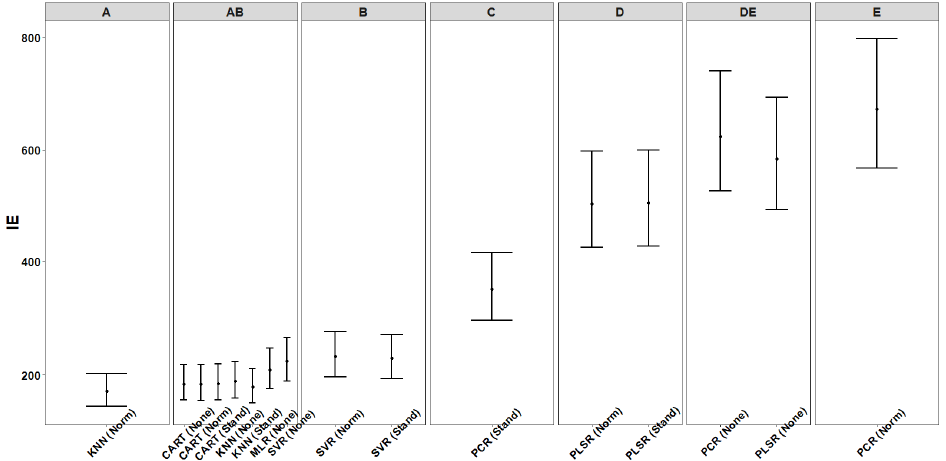
Figure 9. Post-hoc analysis for WS distributions (LMEM on performances of interval estimators).